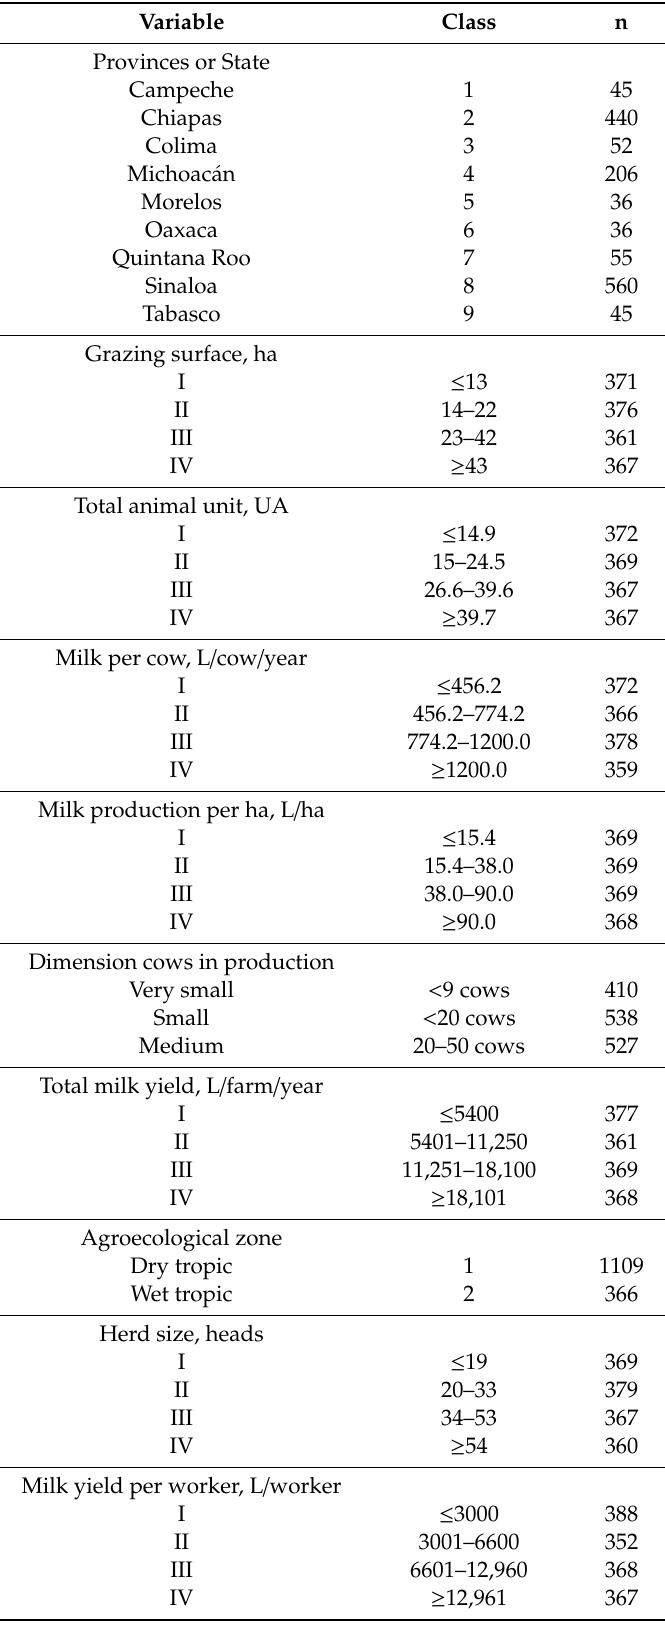
Table 1. Structural indicators and their classes used in the multiple correspondence analysis of smallholder’s dual-purpose system (n =